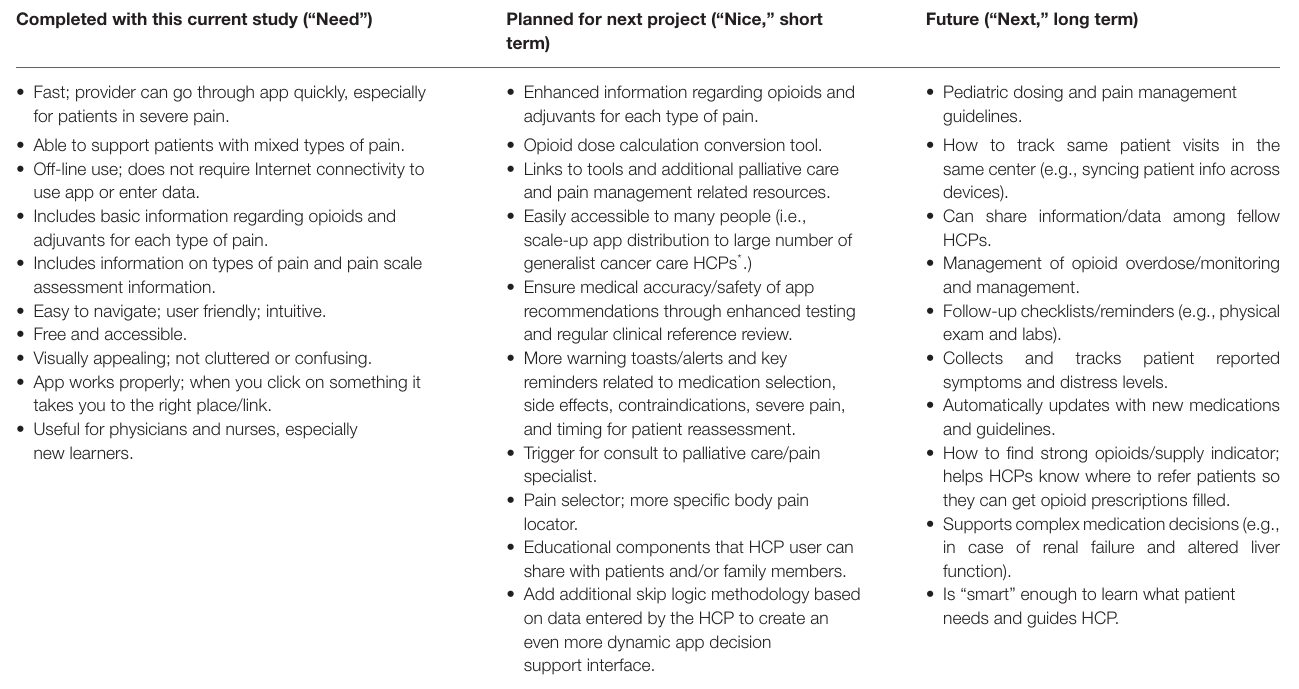
TABLE 2 | Desired features and functionality of the NAPCare mobile app as identified by the Nepal